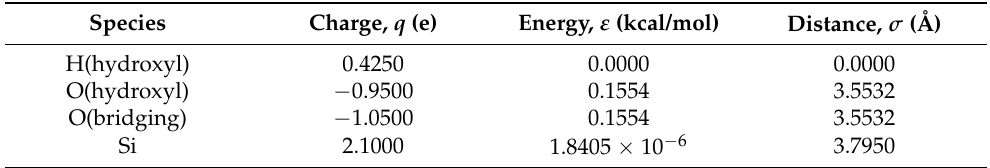
Table 1. The CLAYFF [37] force field has been used to successfully simulate the adsorption properties of heavy oil molecules at oil—rock interactions in previous work [11,13,38]. Table 1. Nonbond potential parameters for CLAYFF force [37]. q represents the charge of an atom, and ε and σ represent the energy and distance between